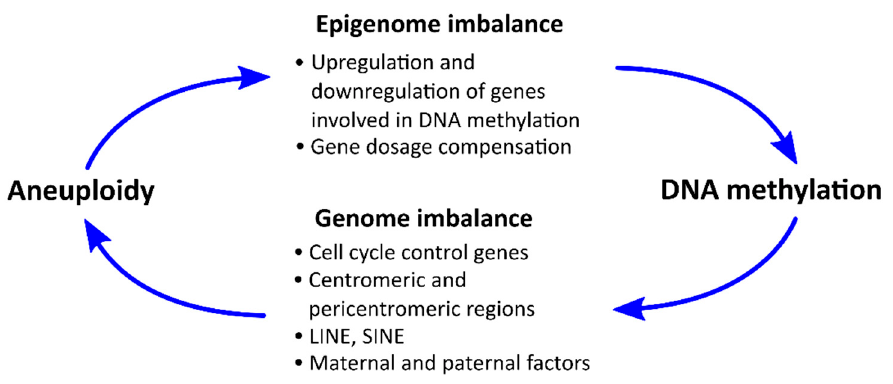
Figure 3. Potential relationships between DNA methylation and aneuploidy.